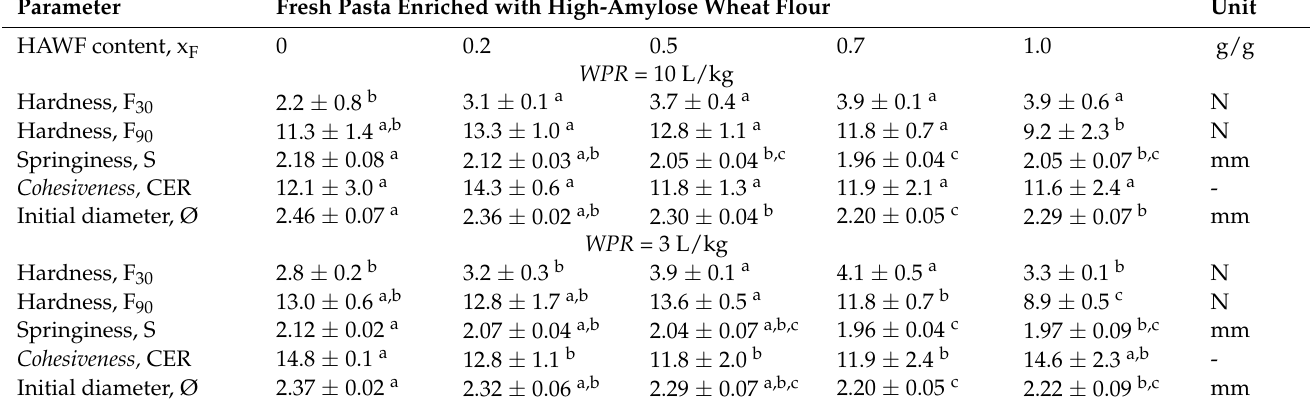
Table 3. Effect of the percentage (x F ) of high-amylose wheat flour in the flour mixture used to prepare fresh pasta samples on the textural properties of cooked pasta strands when using different water-to-pasta ratios (WPR).